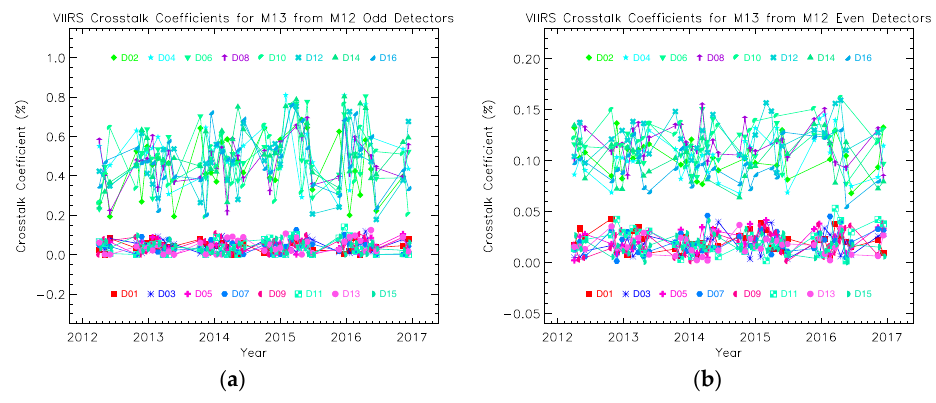
Figure 9. SNPP VIIRS Band M13 crosstalk coefficients for sending Band M12: ( a ) odd detectors and ( b ) even detectors.